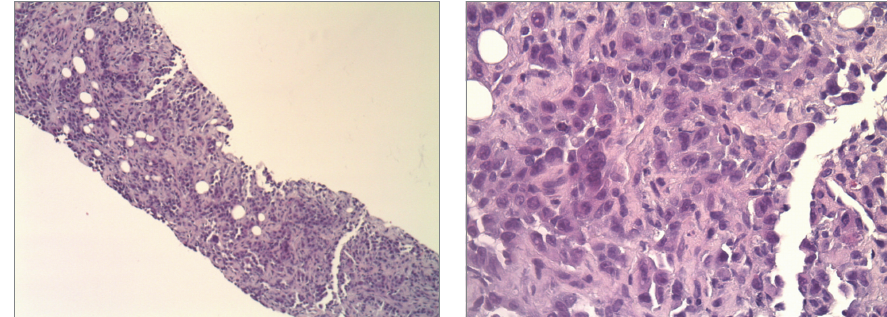
Figure 3: H&E stain of mass.